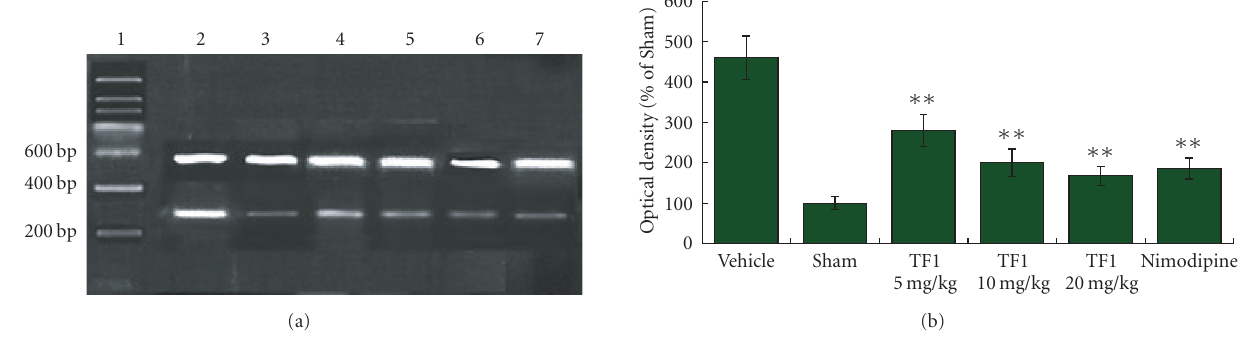
Figure 6: (a) The mRNA expression of iNOS was assessed by using RT-PCR as standardized by coamplifying the housekeeping gene β -actin. Lanes 1–7: Marker, Vehicle, Sham, TF1 (5mg · kg − 1 ), TF1 (10mg · kg − 1 ), TF1 (20mg · kg − 1 ), Nimodipine. (b) Statistical analysis revealed that theaflavin-treatment markedly decreased mRNA expression of iNOS dose dependently, ∗∗ P < .